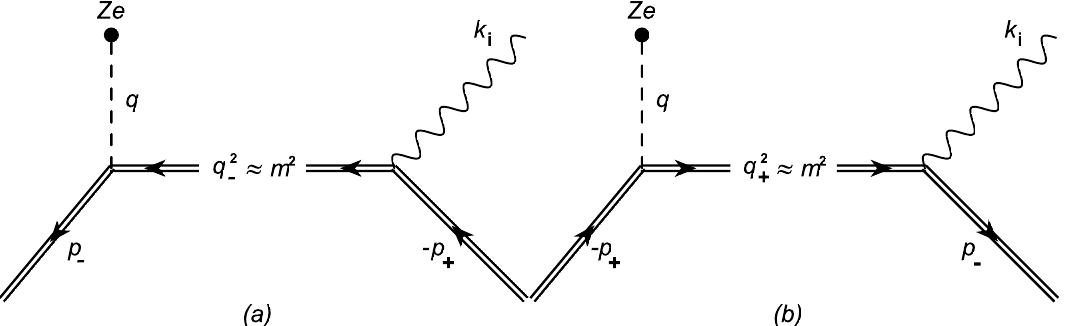
Figure 1. Feynman diagrams of the resonant PPP process on a nucleus in the external electromagnetic field. Double incoming and outgoing lines correspond to the Volkov functions of an electron and a positron in the initial and final states, the inner lines correspond to the Green’s function of the fermion in the external electromagnetic field. Wavy lines represent the initial gamma quantum. Dashed lines stand for the pseudo photon of recoil. The figures ( a ) and ( b ) depict two different channels A and B